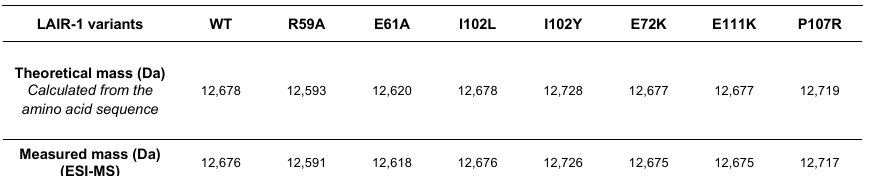
Figure 1. Quality control of the LAIR-1 Ig-like domain variants. ( A ) Summary table of the theoreti- cal masses calculated from the amino acid sequences and the measured masses by ESI-MS experi- ments of the LAIR-1 variants produced. ( B ) SDS-PAGE analysis of the LAIR-1 variants on a 14% polyacrylamide gel under reducing condition.